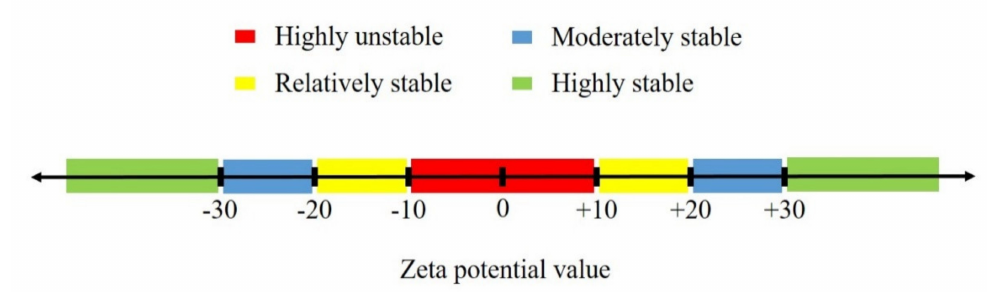
Figure 10. Di ff erent ranges of zeta potential values and the level of stability of nanoparticles into the aqueous phase.